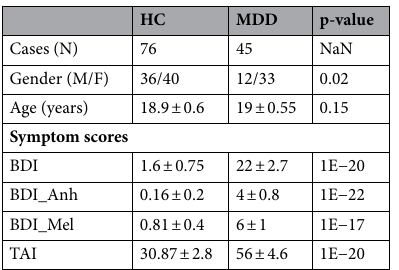
Table 1. Demographics of the 121 participants. BDI_Anh anhedonia subscale of BDI, BDI_Mel Melancholia subscale of BDI, TAI trait anxiety